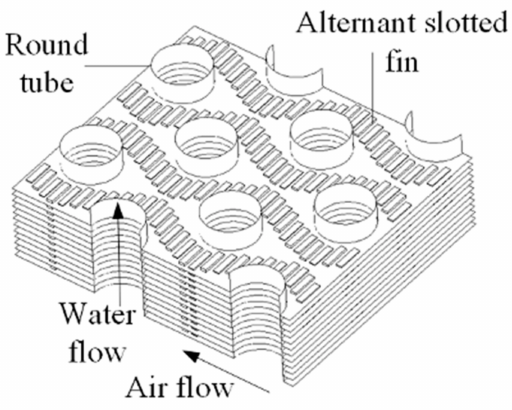
Figure 2. Details of heat exchangers.